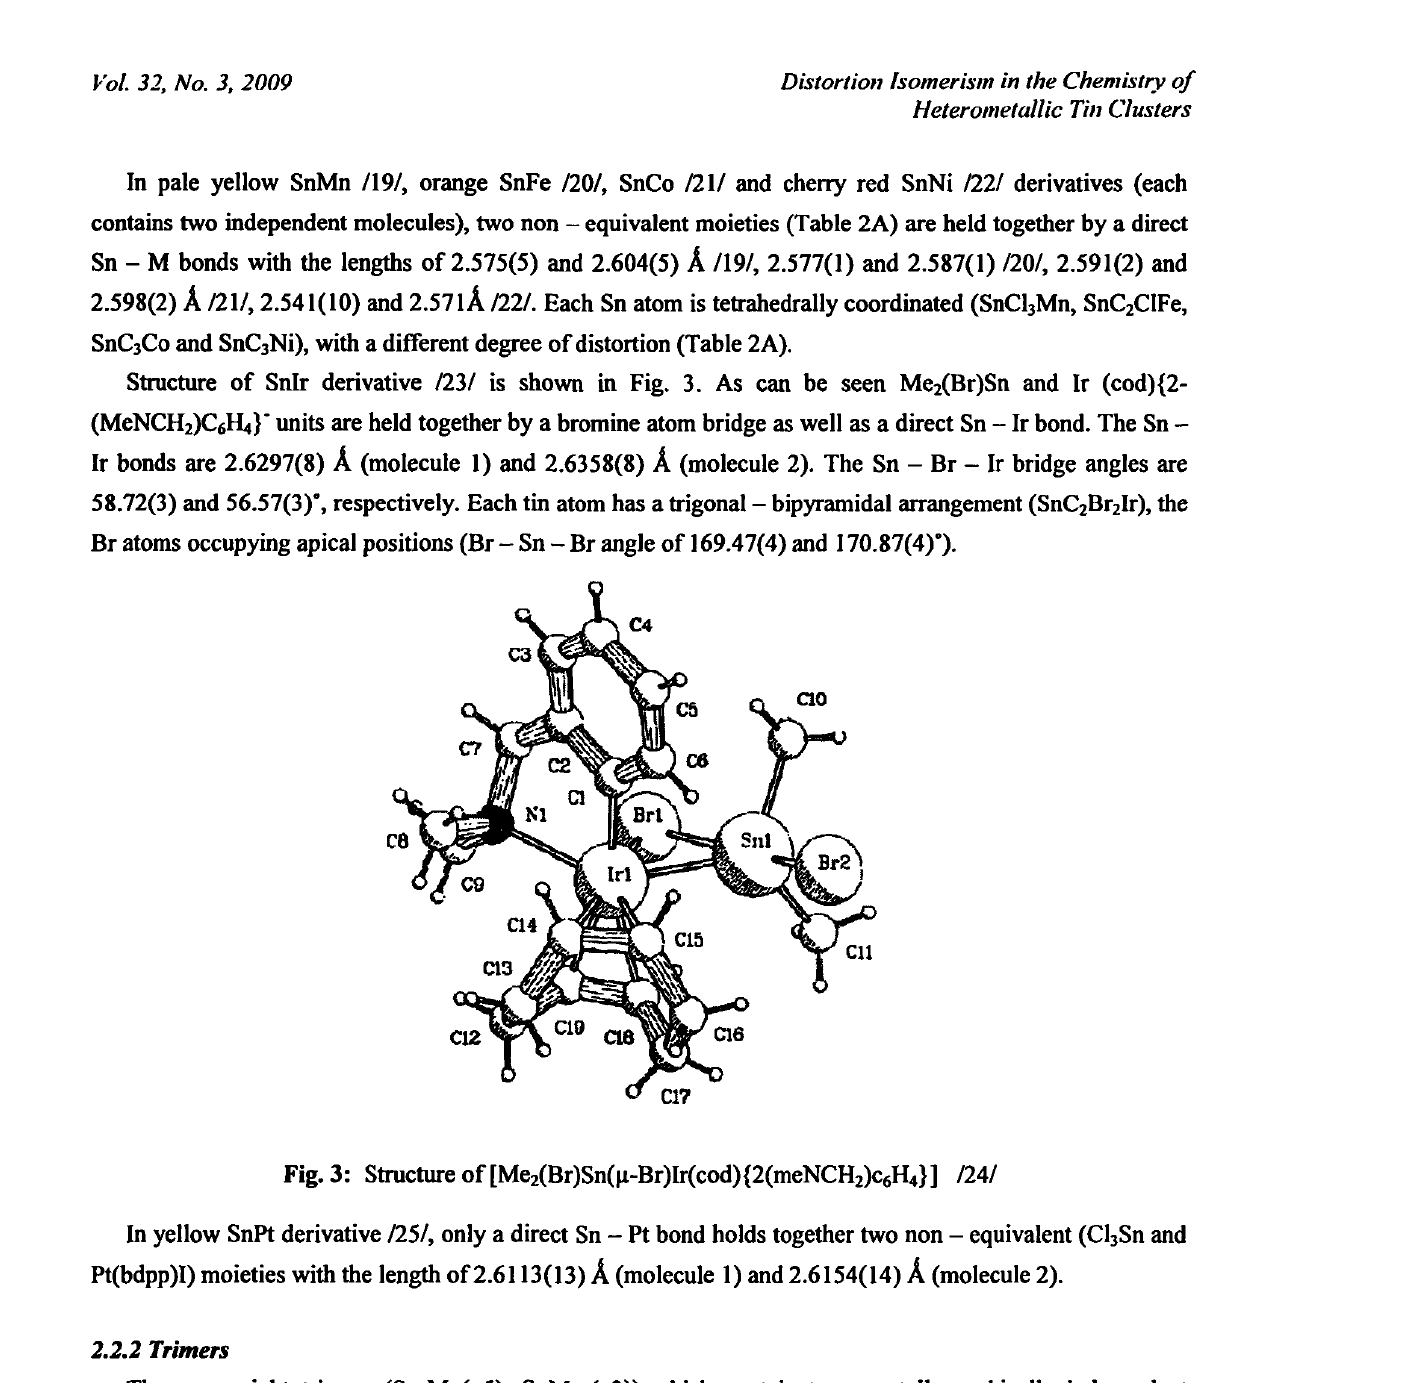
(Br)Snfa-Br)Ir(cod){2(meNCH 2